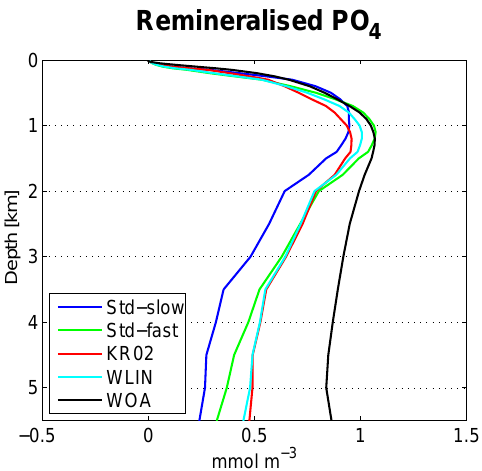
Figure 25. Global mean profiles of remineralised phosphate (mmolm − 3 ) averaged over the last 10 years of the spin-up sim- ulations employing the STD-slow (dark blue), STD-fast (green), KR02 (red), and WLIN (light blue) particle sinking parameterisa- tions. The remineralised fraction of phosphate is approximated by apparent oxygen utilisation (AOU) divided by the stoichiometric Figure 26. Scatter plots of modelled vs. observed POC fluxes at = 172 used in the model. oxygen to phosphorus ratio R O 2000m depth for the POC sinking parameterisations (a) STD- 2 : P slow, (b) STD-fast, (c) KR02, and (d) WLIN. Observed data are taken from a synthesis of sediment trap POC fluxes compiled by Honjo et al. (2008). Data from several stations are averaged if they are located in the same model grid cell. Stations are discarded if the depth in the corresponding model grid cell is shallower than 2000m. Model–data pairs are colour coded according to ocean basin and latitudinal range: Atlantic north of 40 ◦ N (dark blue), subtropical Atlantic (blue), tropical Atlantic (light blue), Pacific north of 40 ◦ N (dark green), subtropical Pacific (green), tropical Pa- cific (light green), tropical Indian Ocean (yellow), Arabian Sea (or- ange), Southern Ocean between 40 and 60 ◦ S (brown), and South- ern Ocean south of 60 ◦ S (red). Here, the term “subtropical” refers to latitudes between 20 and 40 ◦ N as well as 20 and 40 ◦ S, and the term “tropical” refers to latitudes between 20 ◦ N and 20 ◦ S. Colour codes are also shown in the inset in panel (a)